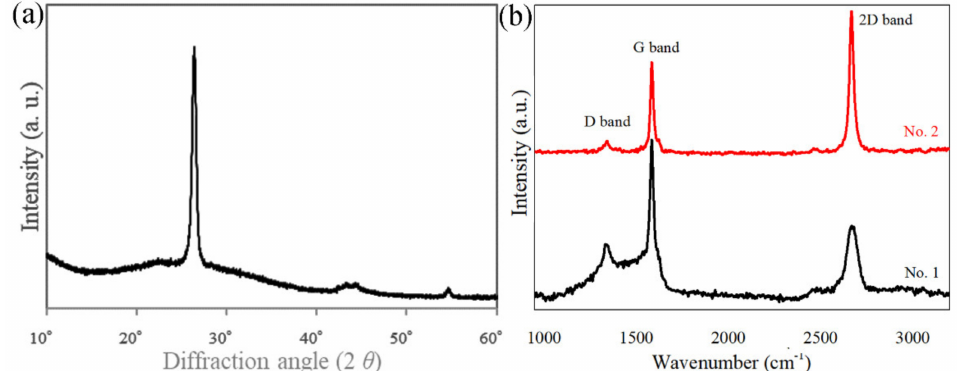
Figure 4. ( a ) XRD pattern of the recovered sample and ( b ) Raman spectra of graphite strip (No. 1) and recovered sample (No. 2).